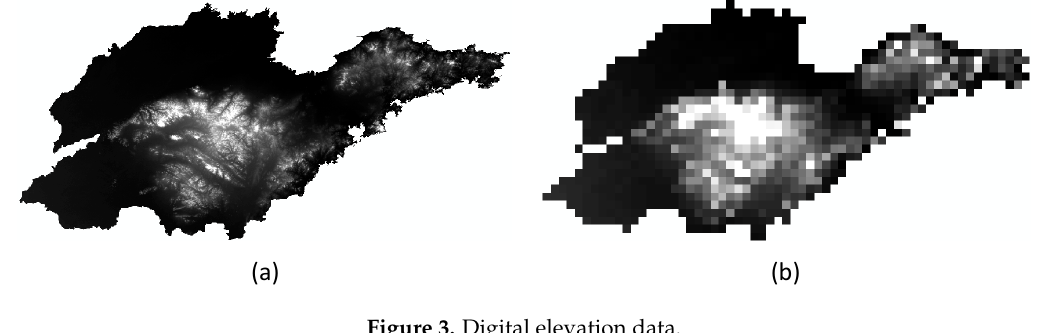
Figure 3. Digital elevation data.